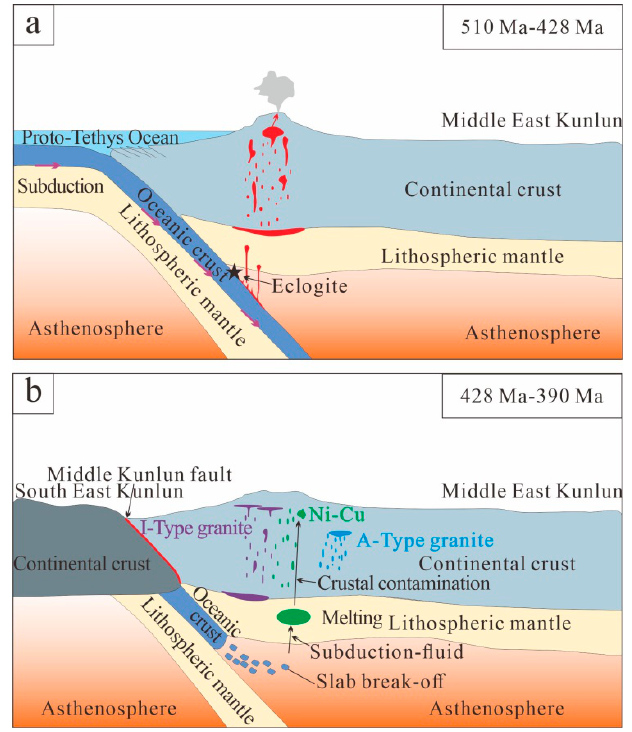
Figure 9. Geological evolution in the EKOB between 510 and 390 Ma. ( a ) The Proto - Tethys Ocean subducted between 510 and 428 Ma.; ( b ) The post-collision extension setting between 428 and 390 Ma.